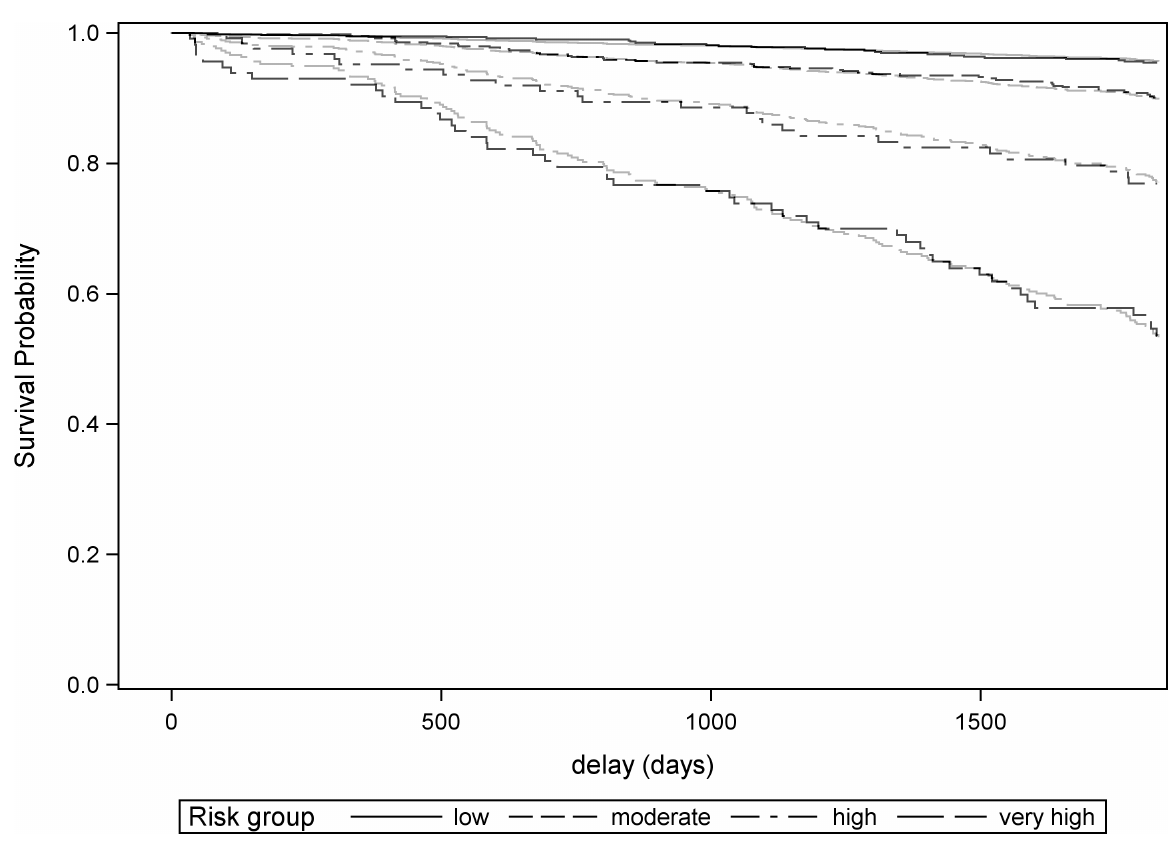
Fig 2. Assessment of model calibration: Observed (Kaplan Meier, black) versus predicted (Cox, gray) survival curves.